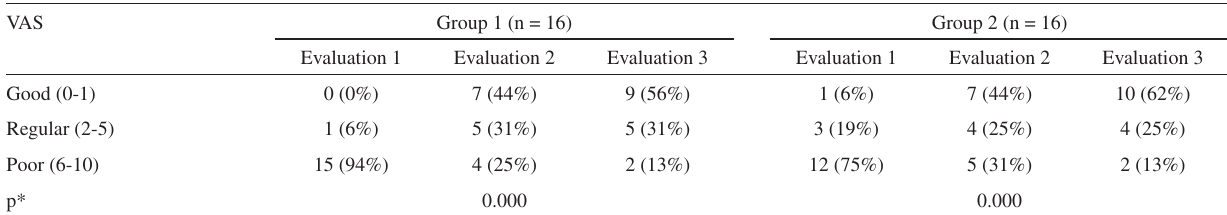
Table 3 – Patient distribution according to intensity of morning pain on visual analog scale (VAS) in Groups 1 and 2 before and after treatment VAS